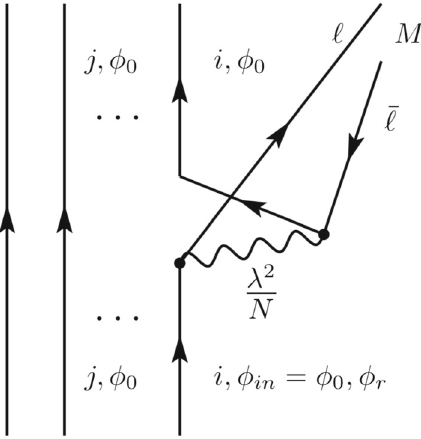
Fig. 2 Feynman diagrams for meson-baryon trilinear coupling in the large N limit. An excited quark emits a gluon, turning into a quark- antiquark pair with the factor λ 2 /